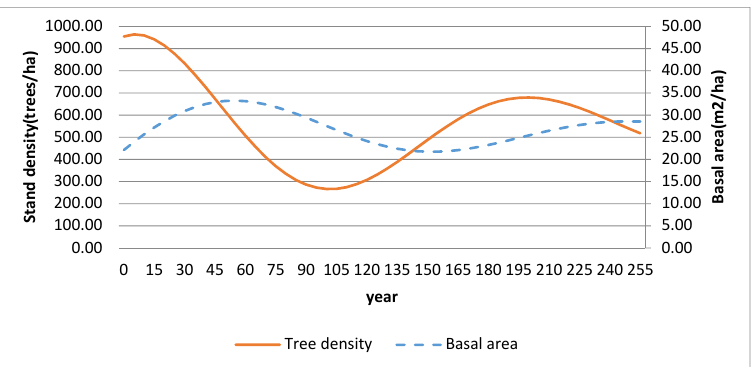
Figure 2. Diameter distributions over 200 years.